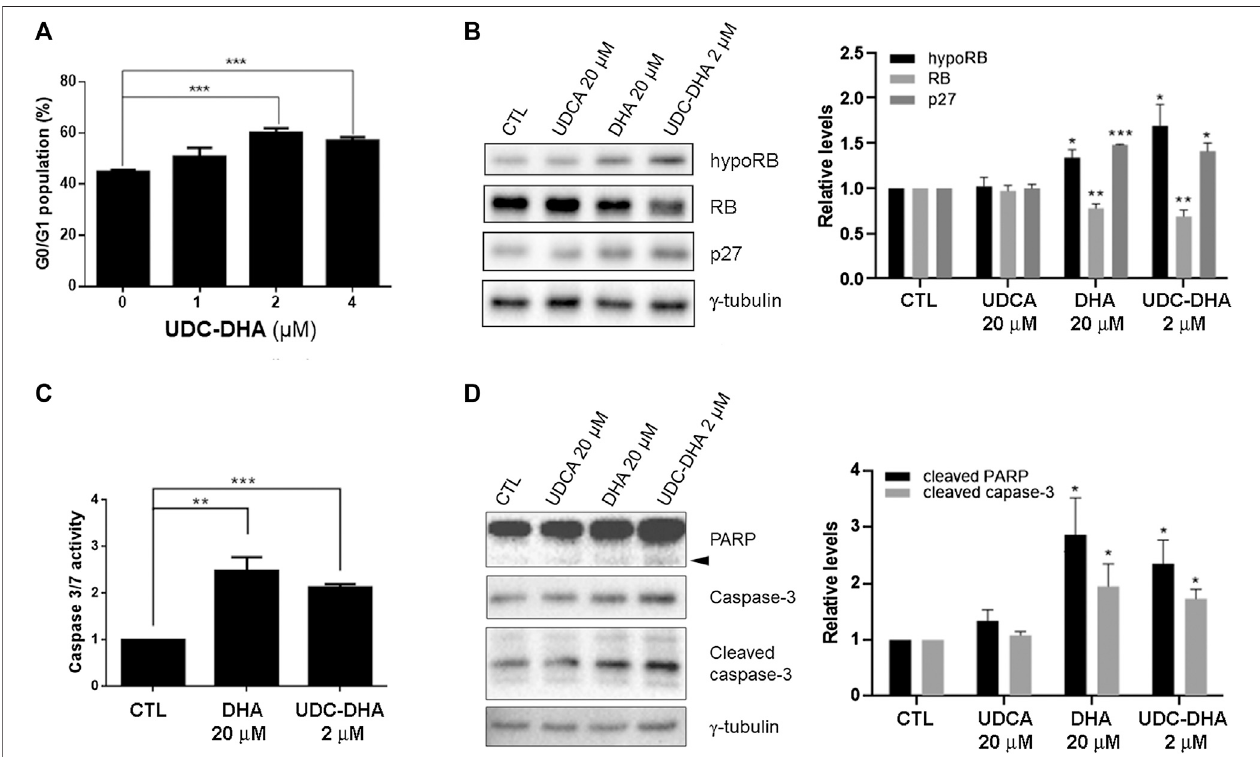
FIGURE3| EffectsofUDC-DHAoncellcycleprogressionandapoptosisinHepG2cells. (A) TreatmentwithUDC-DHAfor24 hincreasedtheG0/G1population in adose-dependentmanner.HepG2cellsweretreatedwithUDC-DHAfor24 hfollowedbyPIstainingand fl owcytometricanalysis. (B) DHAandUDC-DHAincreasedthe levels of G0/G1 protein markers hypophosphorylated RB (hypoRB) and p27 in HepG2 cells. Cells were treated with indicated concentrations of DHA, UDCA and UDC- DHA for 24 h and harvested for Western blot analysis. (C) DHA and UDC-DHA induced caspase 3/7 activity in HepG2 cells. Cells were treated with indicated concentrationsofDHAandUDC-DHAfor72 handsubjectedtotheCaspase-Glo3/7assay. (D) DHAandUDC-DHAincreasedthecleavageofPARPand casapse-3in HepG2 cells. Cells were treated with indicated concentrationsofDHA, UDCA and UDC-DHA for 72 h and harvested for Western blot analysis.Cleaved PARPismarked by an arrowhead. Relative protein levels were quanti fi ed by Image Lab software and γ -tubulin was used as a loading control. Data are presented as mean ± SEM of at least three independent experiments. Statistical signi fi cance wasevaluatedbytwo-tailedStudent ’ s t -test compared tothe vehicle control (CTL). *, p < 0.05; **, p < 0.01; ***, p <